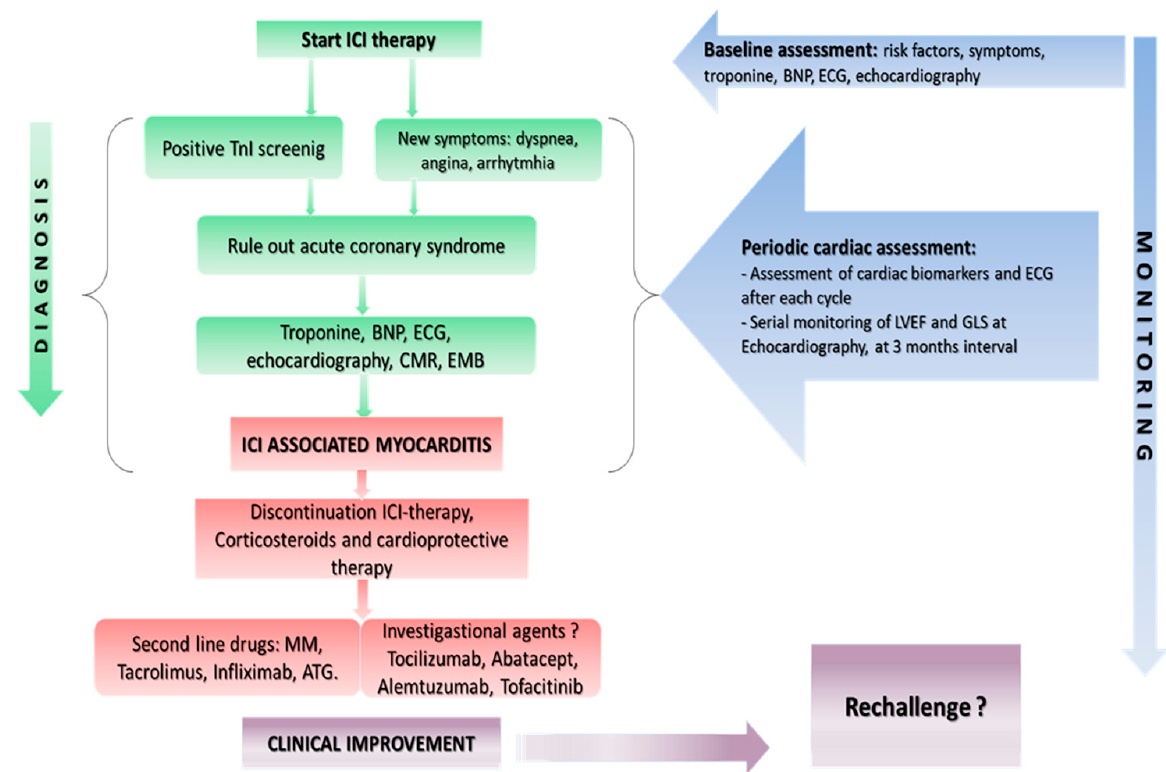
Figure 2. An algorithm for the clinician to make diagnosis of myocarditis and monitoring of cardiovascular toxicity ICI induced. Overview of first-, second-line treatment and investigational agents for ICI-associated cardiotoxicity.